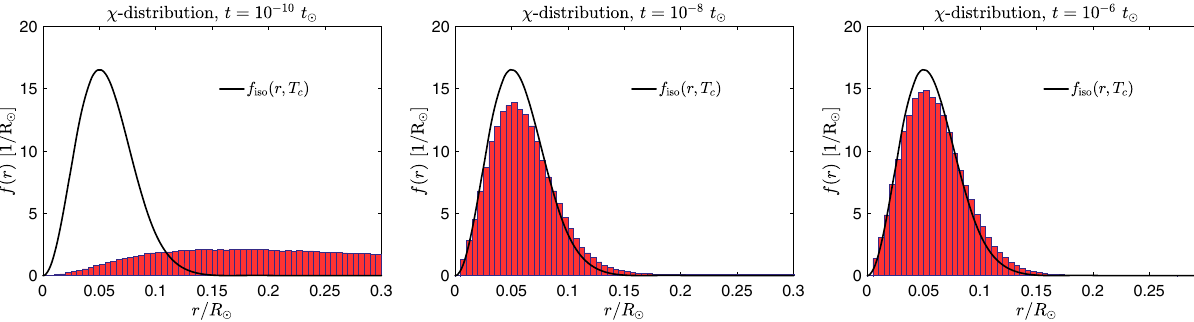
Fig. 5 The radial distribution of elastic DM at times: t = 10 − 10 t (cid:9) ( left panel ), t = 10 − 8 t (cid:9) ( middle panel ) and t = 10 − 6 t (cid:9) ( right panel ). We fix m χ = 5